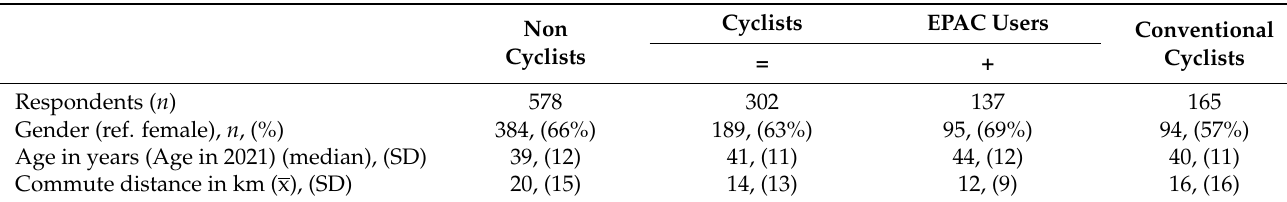
Table 2. Descriptives of different